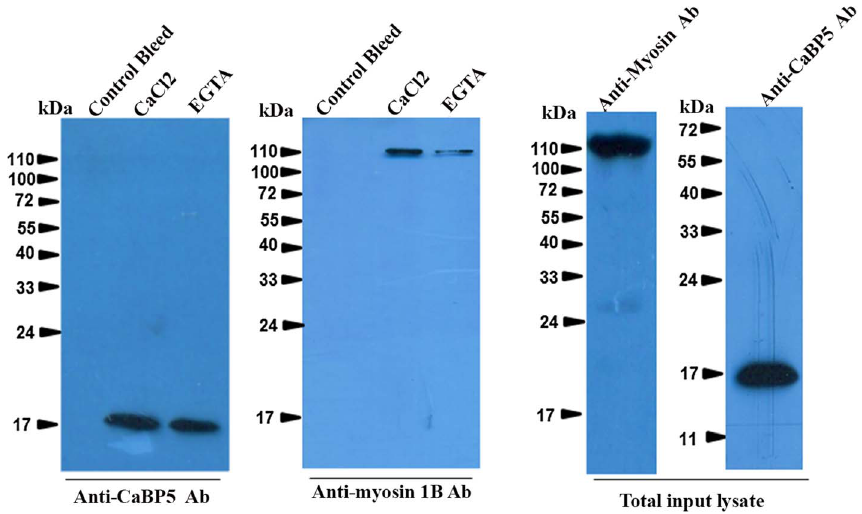
Fig 4. Interaction of EhCaBP5 with myosin 1B. Total (800 m g) E. histolytica lysate was incubated with Sepharose-anti-CaBP5 antibody conjugate for 6 h at 4 u C with shaking. The beads were then washed and the bound material was then eluted and analysed by western blotting followed by immunostained with anti-myosin 1B antibody raised in rabbit. The blot was reprobed with anti-CaBP5 antibody raised in mice. The total input lysate was also probed for the presence of EhCaBP5 and myosin 1B by their respective antibodies.